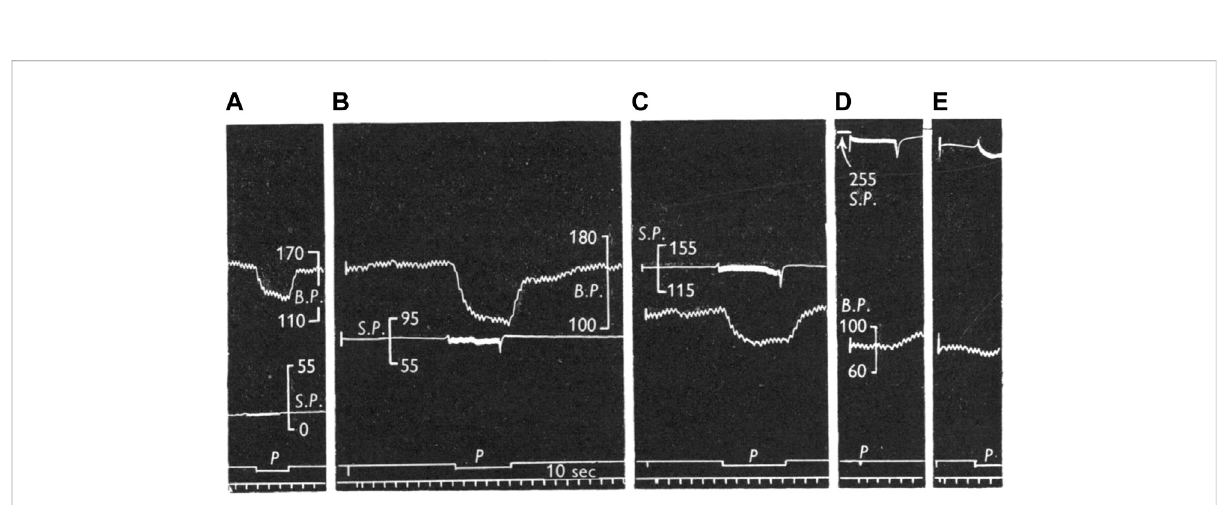
FIGURE 13 Comparison of re fl ex effects of pulsatile and non-pulsatile carotid sinus perfusion at mean pressures of 15 (A) , 80 (B) , 135 (C) , 240 (D) , and 235 (E) mmHg in the cat. Traces: BP, systemic blood pressure; SP, sinus perfusion pressure; p , indicates pulsatile; signal marker, time in I0 sec intervals. [Figure 3 (Ead et al.,